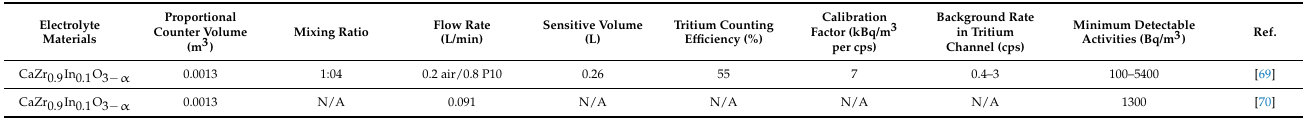
Table 1. Zirconate-based tritium monitoring